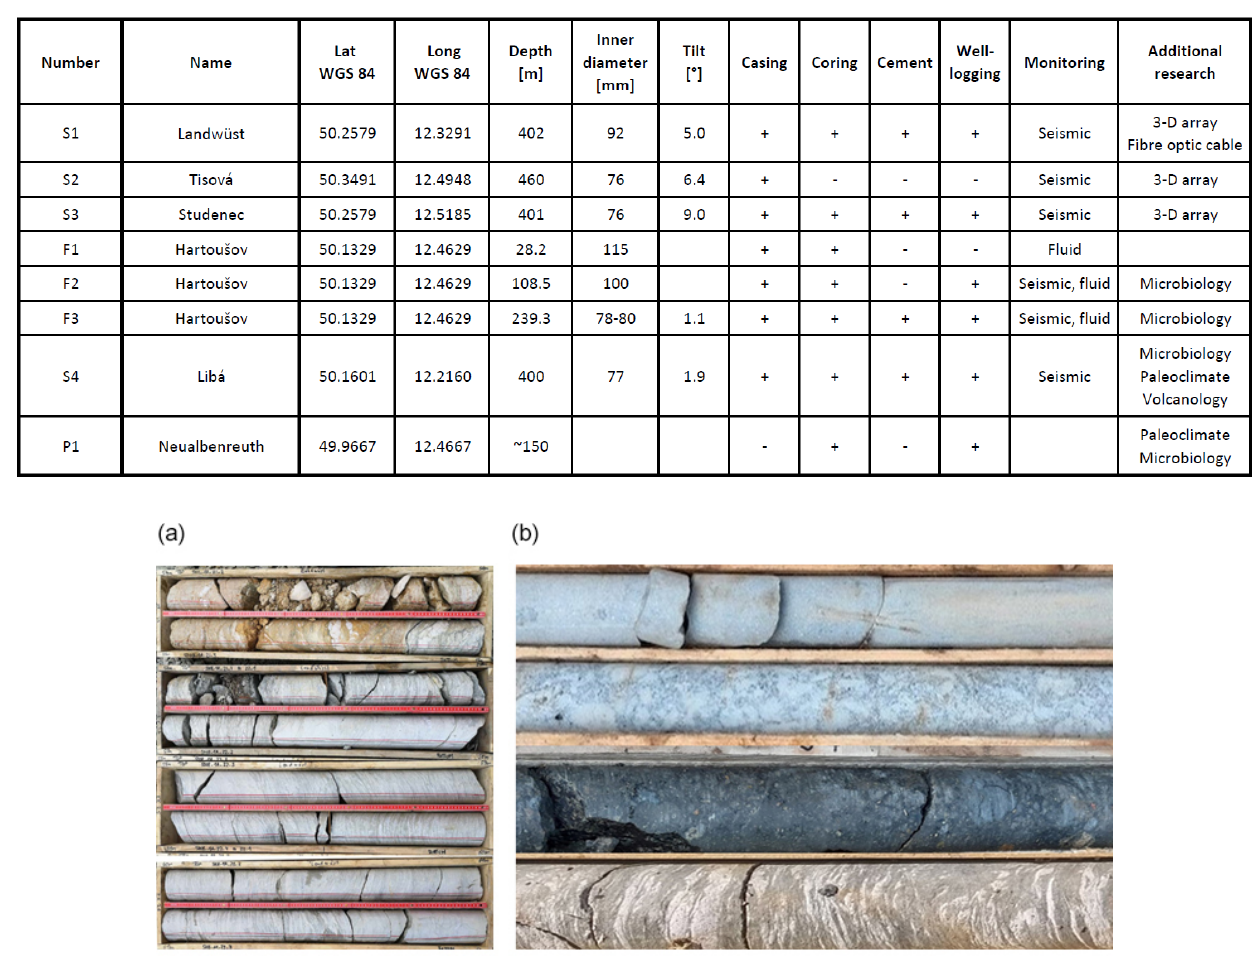
Table 1. Parameters of the drill holes.